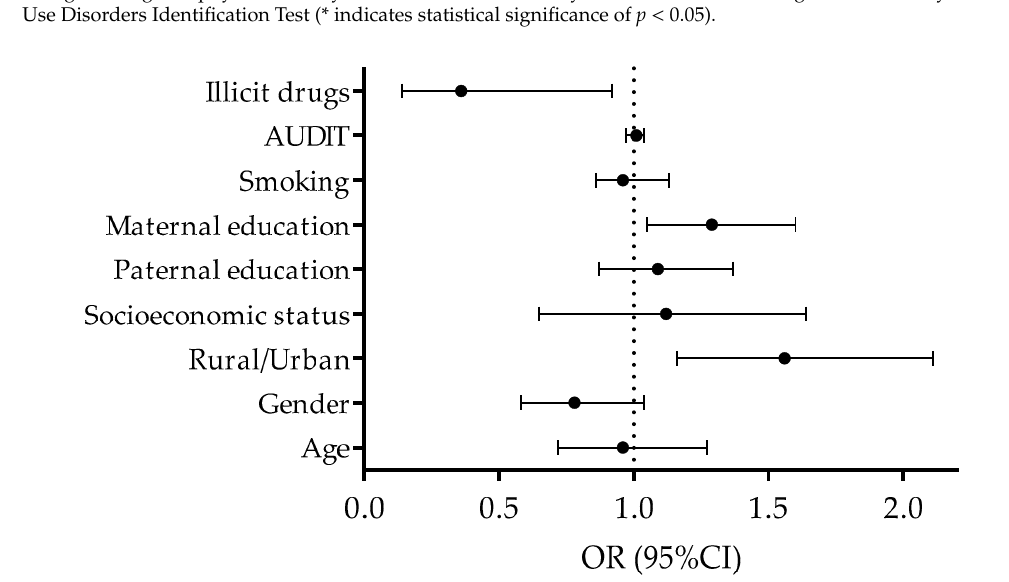
Figure 3. Correlates of decline/incline in PA level over the course of the study (OR-Odds Ratio, 95% CI-95% Confidence Interval).